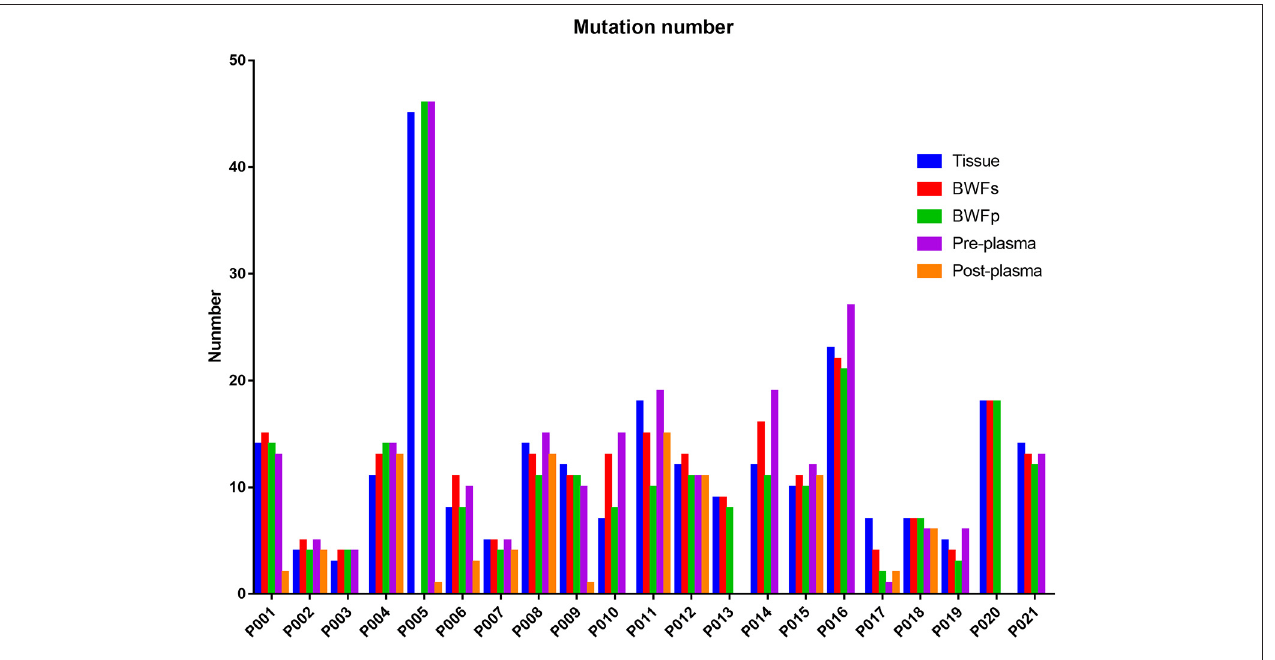
FIGURE 1 | Mutation number in different sample types for each